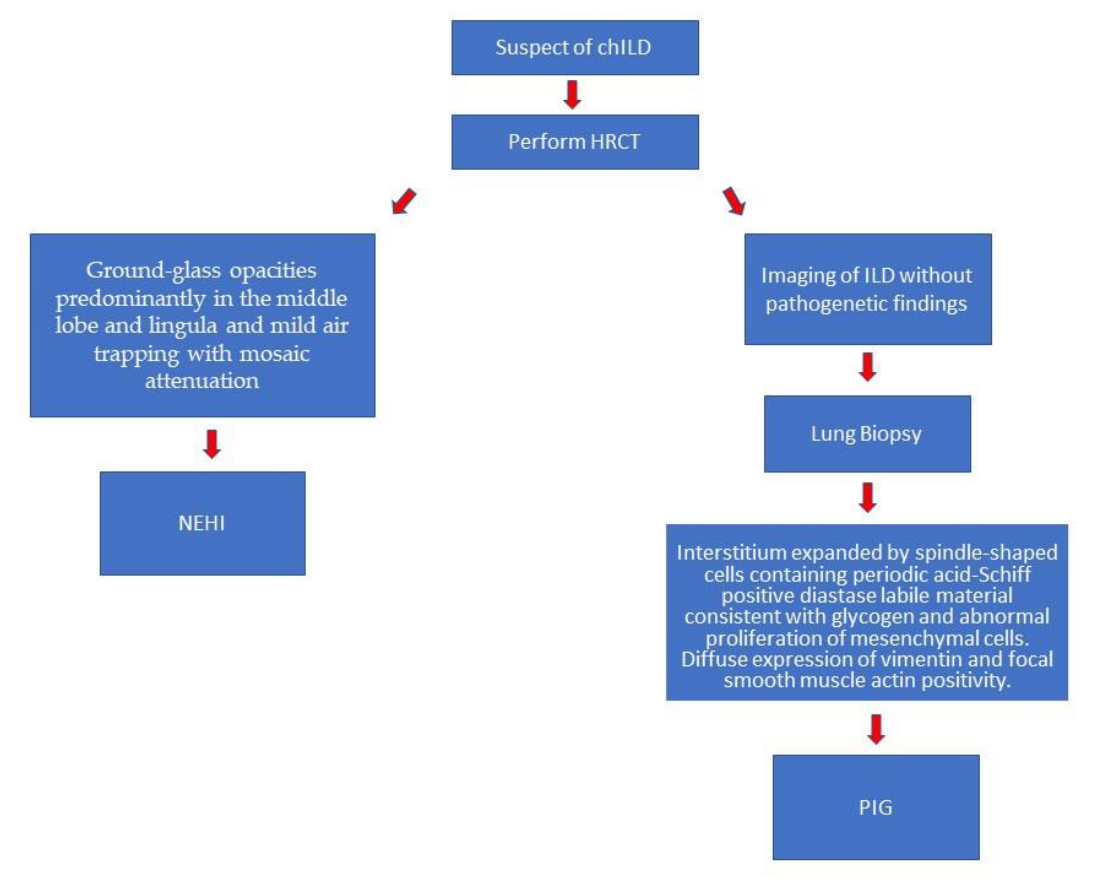
Figure 1. Diagnostic flow-chart .